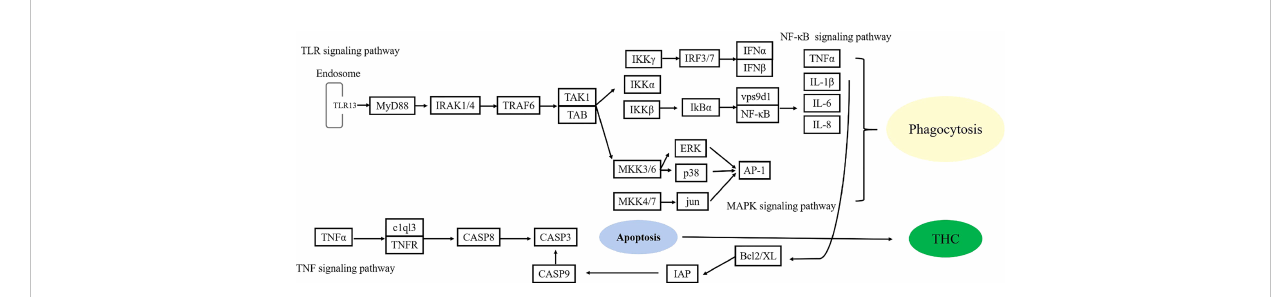
FIGURE 7 The possible signal transduction of immunostimulation mediated by sul fi